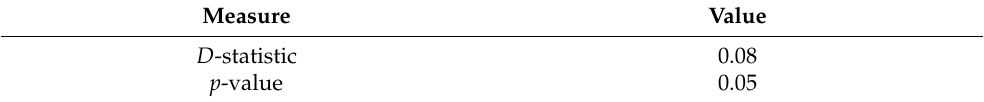
Figure 4. Scatter plot of the CMPC and IPSA monthly returns. Table 3. Lilliefors normality statistic and its p -value for CMPC monthly